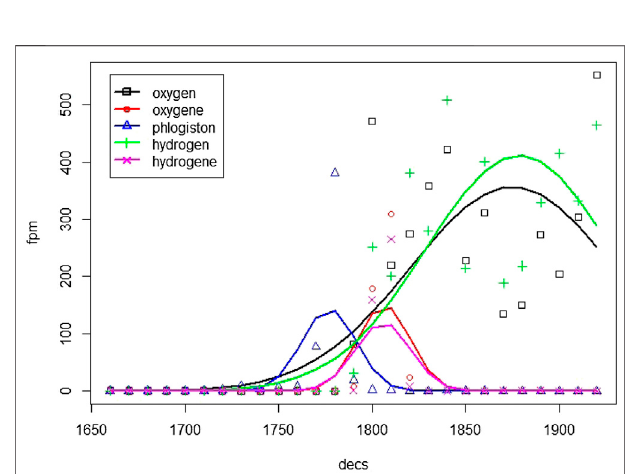
FIGURE 6 | Conventionalization by substitution for oxygene